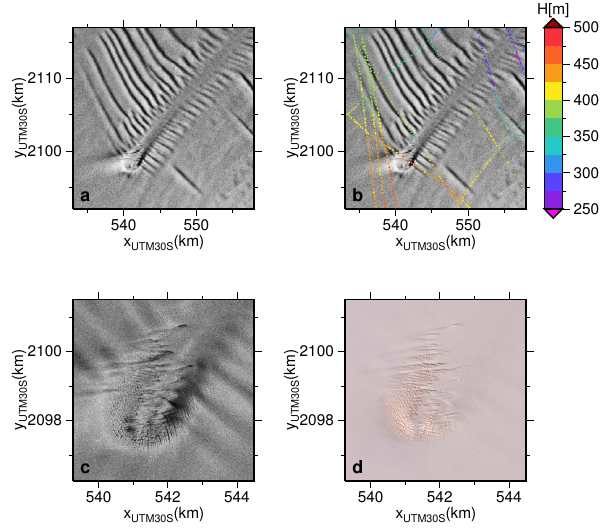
Fig. 6. Details of the ice rumple: (a) TerraSAR-X ScanSAR image taken on 5 November 2009. (b) same as (a) with superimposed RES ice thickness data. (c) TerraSAR-X stripmap mode image from 25 November 2008. (d) ASTER image of the same area as (c) from 6 August